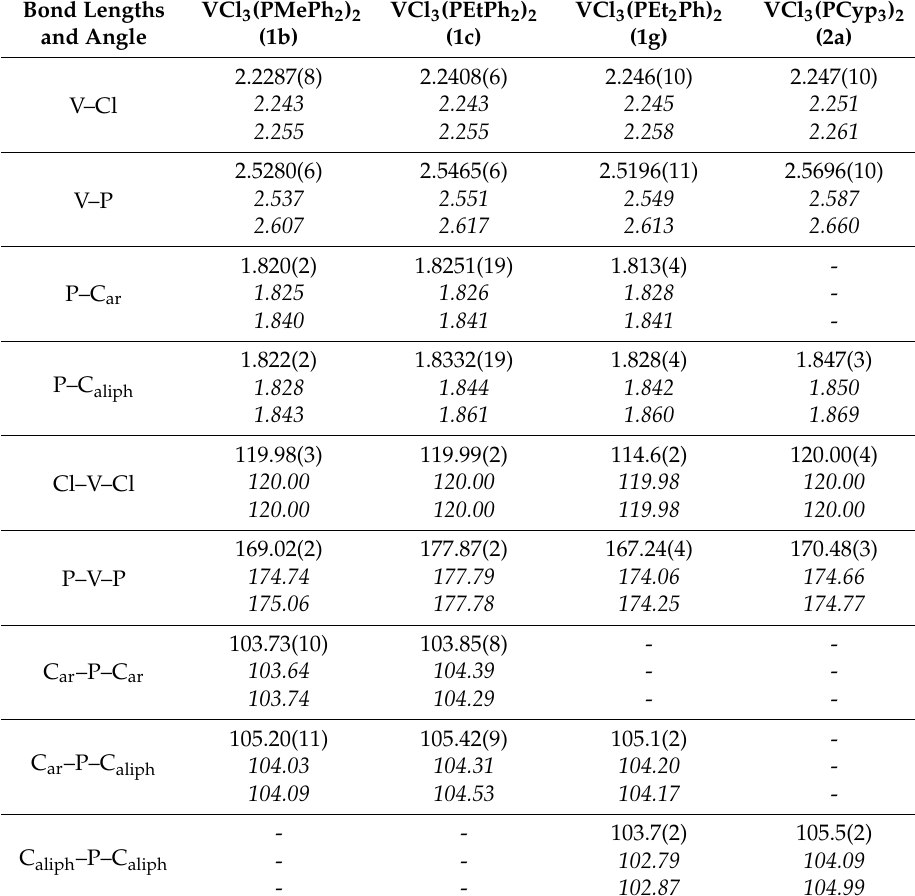
Table 1. Selected X-ray (first row) and Computed (UM06/6-311g(d) and UB3LYP/6-311g(d), second and third row, respectively, in italics) Bond Lengths (Å) and Angles ( ◦ ) for 1b [30] , 1c , 1g and 2a a . Bond